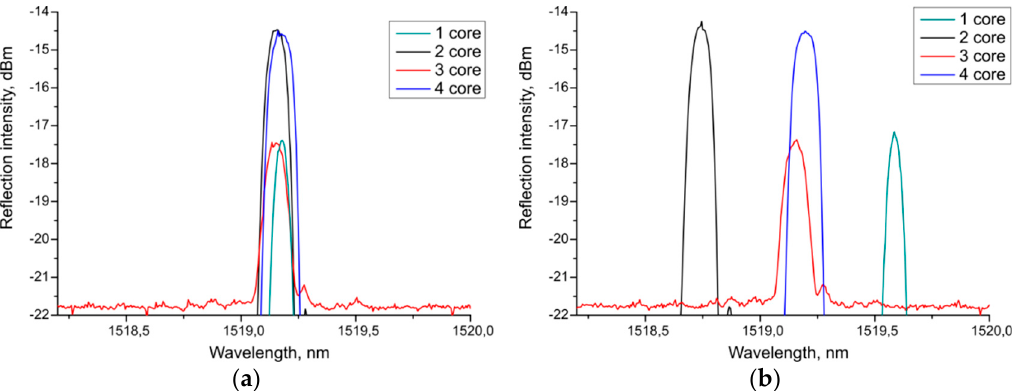
Figure 5. The spectra of four channels of the sensor: ( a ) Straight sensor; ( b ) under the transverse deformation a = 10 mm and θ ≈ − 2°.